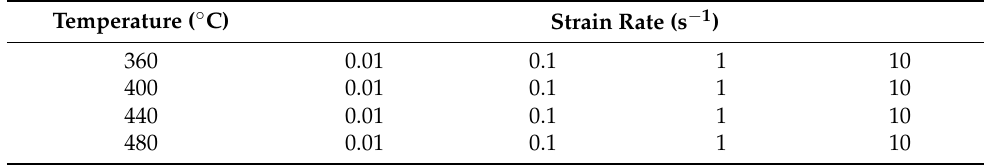
Table 2. Gleeble Experimental